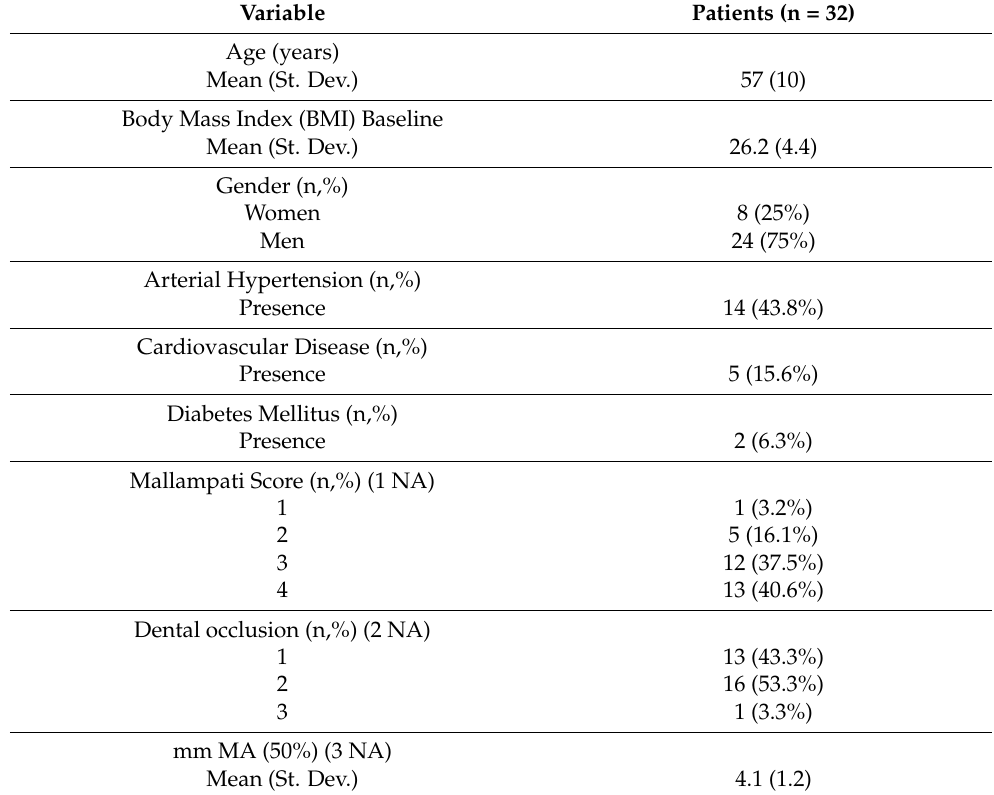
Table 1. Baseline Patient